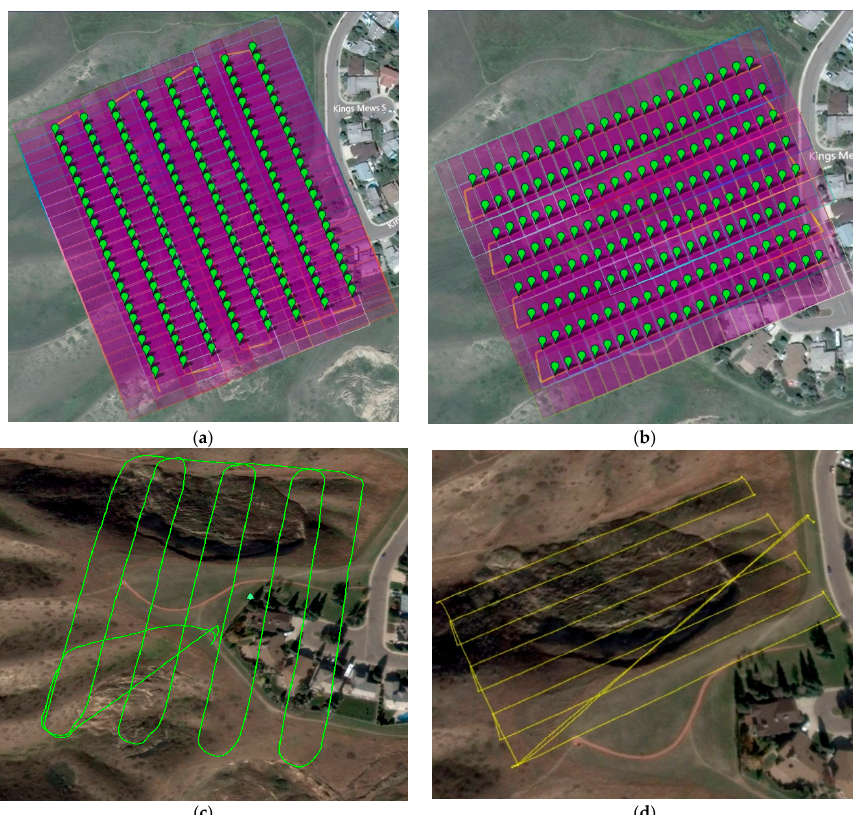
Figure 3. Graphical interface of the image capturing mission flight plan designed to cover study